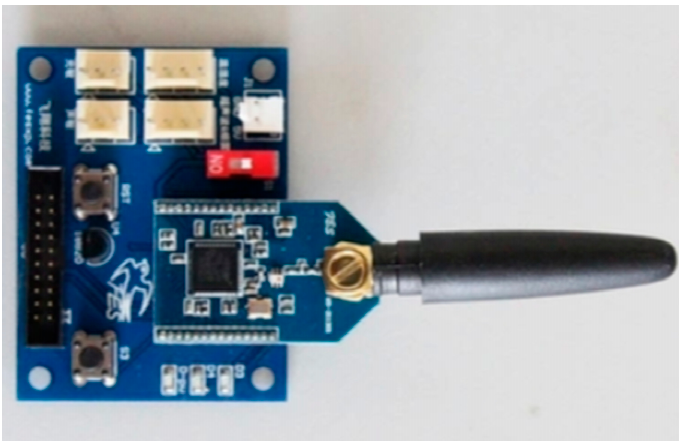
Figure 3. Sensor network node physical map.